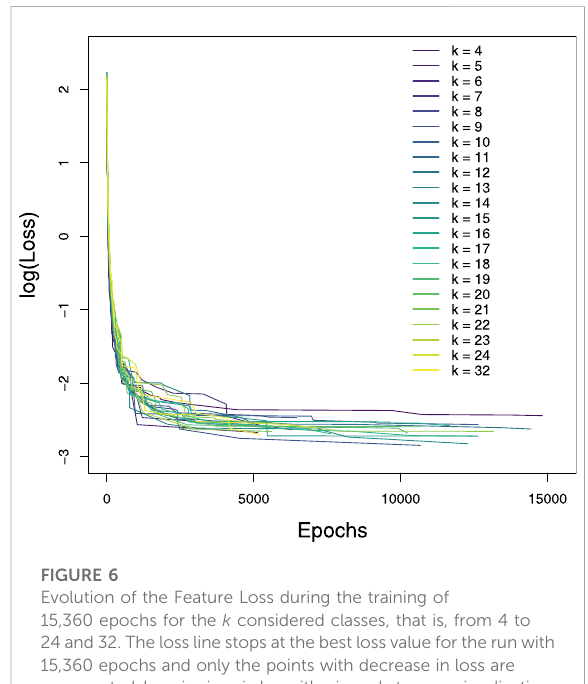
FIGURE 6 Evolution of the Feature Loss during the training of 15,360 epochs for the k considered classes, that is, from 4 to 24 and 32. The loss line stops at the best loss value for the run with 15,360 epochs and only the points with decrease in loss are